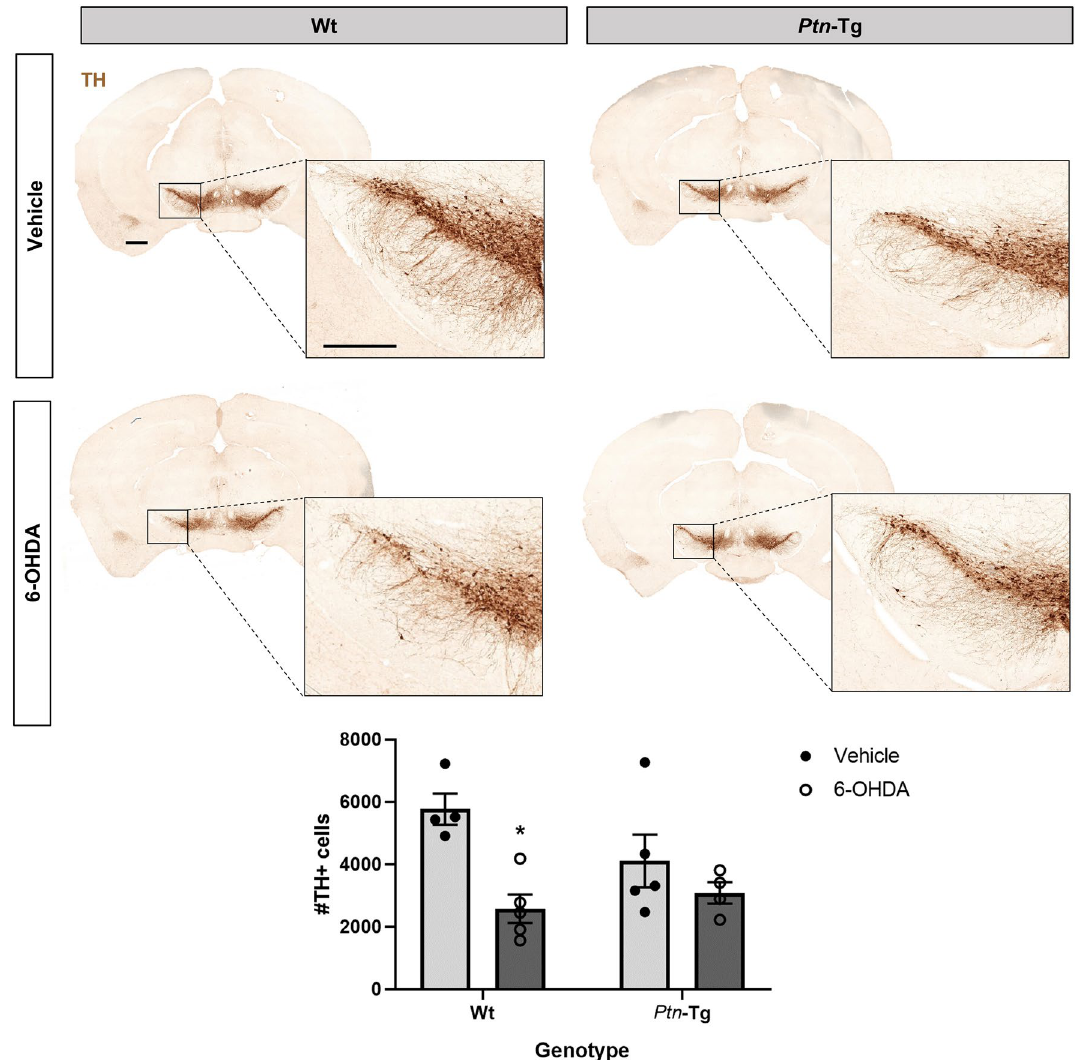
Figure 1. 6-OHDA induces loss of TH+ neurons in the substantia nigra of Wt mice. Photomicrographs of substantia nigra of TH-immunostained sections from mice sacrified 10 days after vehicle or 6-OHDA striatal injection. Graph shows the number of TH+ cells in the substantia nigra pars compacta counted by stereology. Data are represented as mean ± S.E.M. *P < 0.05 vs. Wt-Vehicle. Scale bar = 500 μm (magnification image scale bar = 300